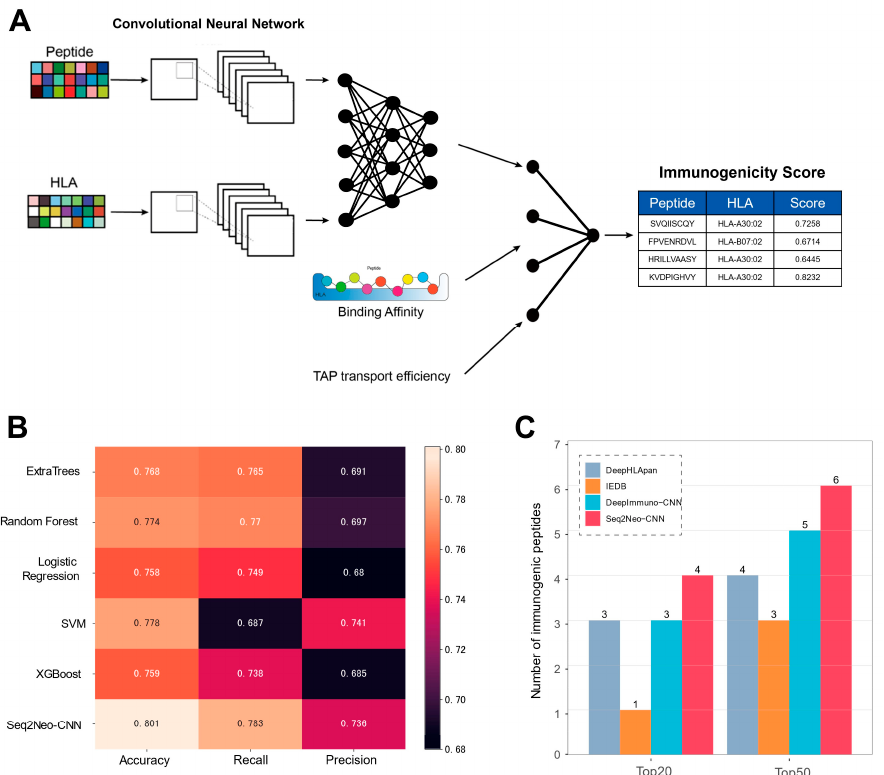
Figure 5. Our convolutional neural network-based model (Seq2Neo-CNN) for peptide immunogen-